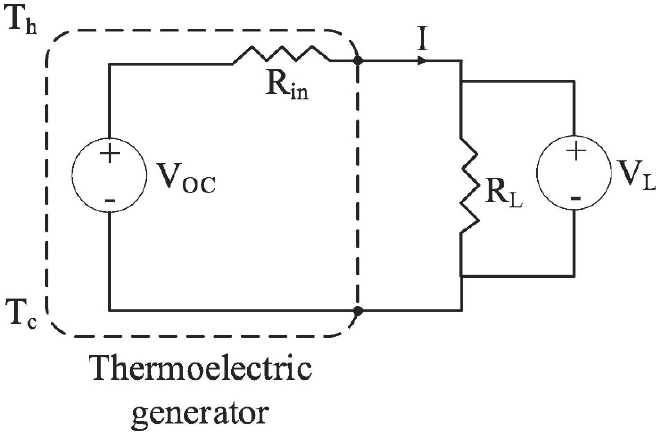
Figure 1. TEG Equivalent electrical circuit [16] .